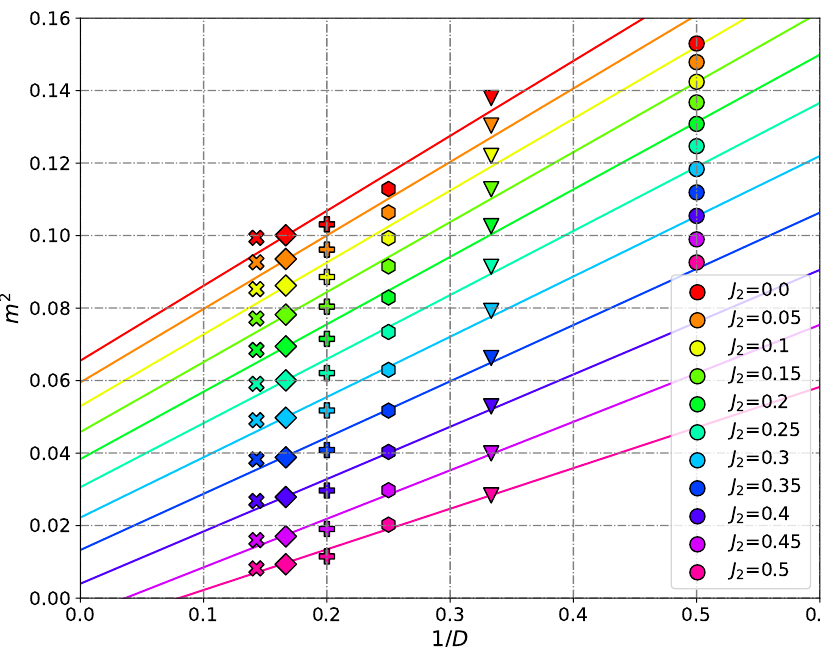
Figure 8: Linear extrapolation in 1 / D for the C with bond dimensions D = 2,...,7 denoted by circles, triangles, hexagons, pluses, diamonds, and crosses in the same order ( D = 2 data is excluded from the fit). Data is the same as in Fig.